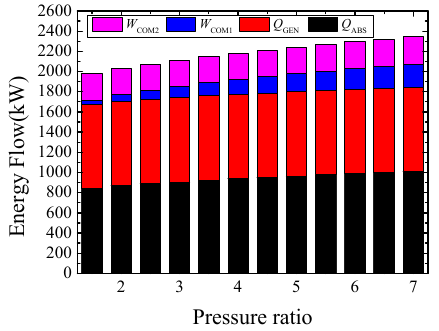
Figure 13. Effect of pressure ratio on the energy flow.